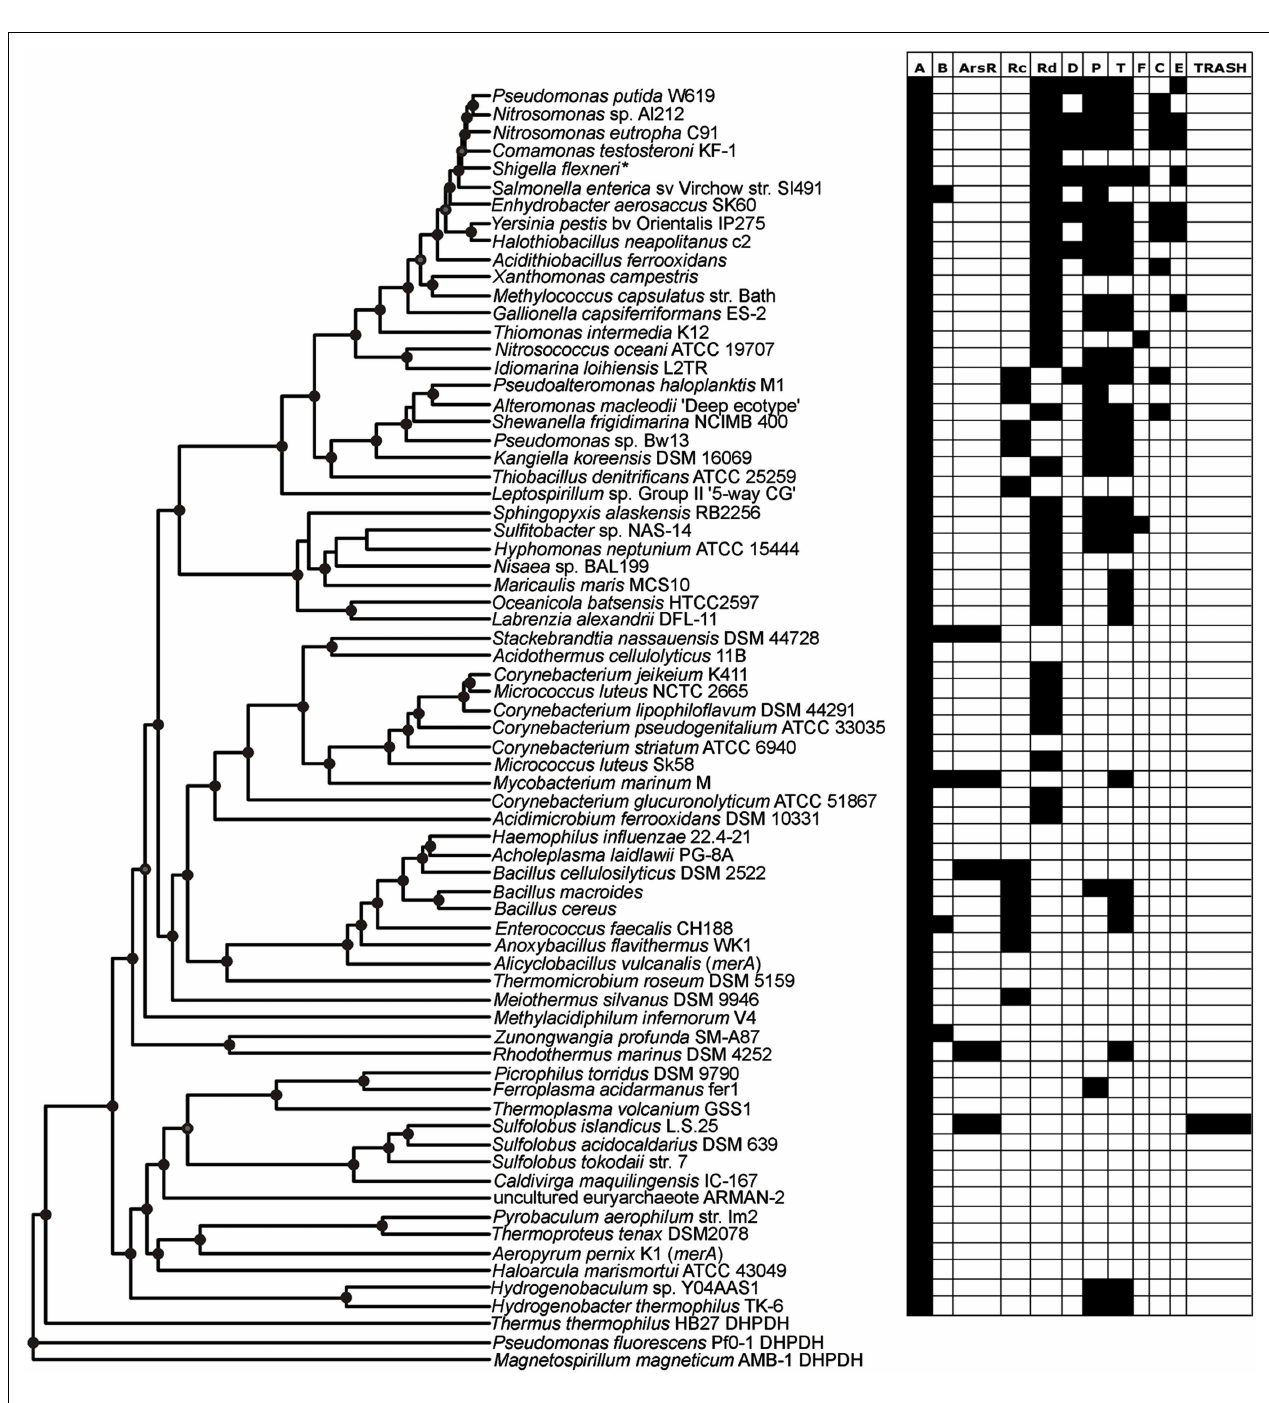
FIGURE 4 | Rate smoothed phylogenetic tree of representative MerA and the distribution of individual mer functions encoded in the associated operon.